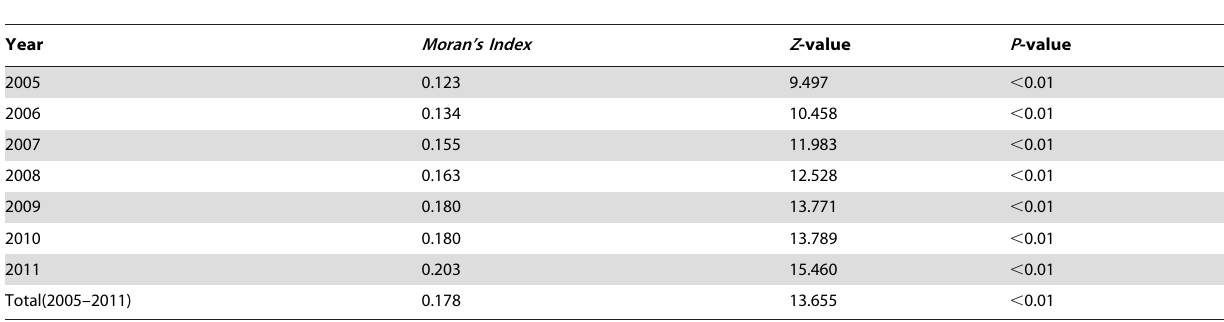
Table 1. Results of general spatial autocorrelation of from 2005 to